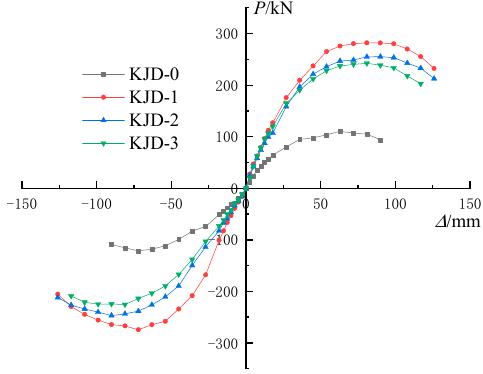
Figure 10. Skeleton curves of each specimen.